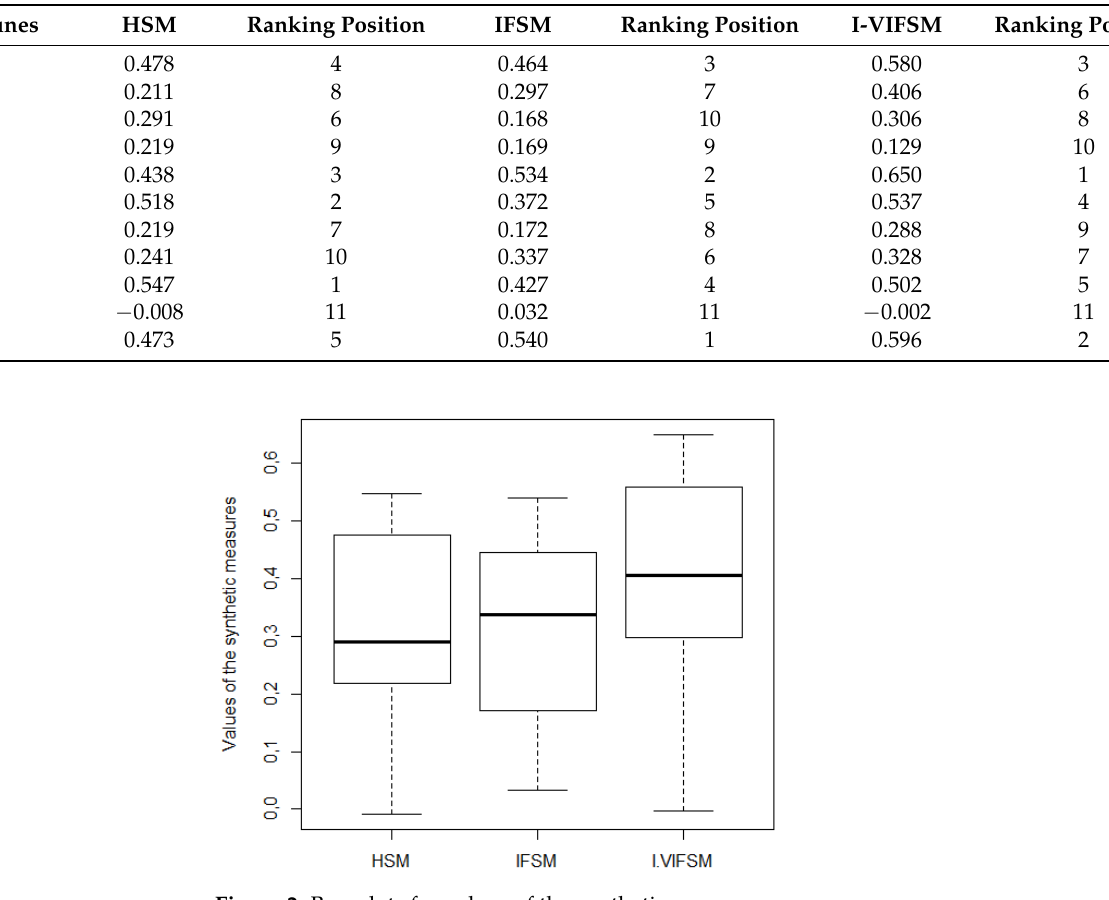
Figure 2. Box-plots for values of the synthetic measures.